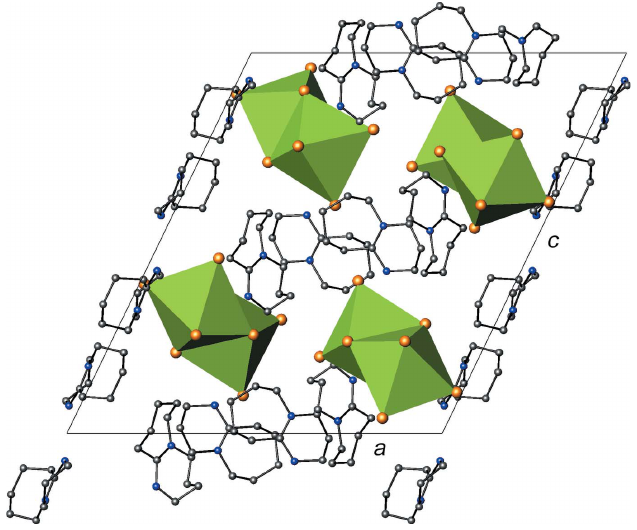
Figure 2 View of the packing of the title compound along [010]. Key: bismuth,